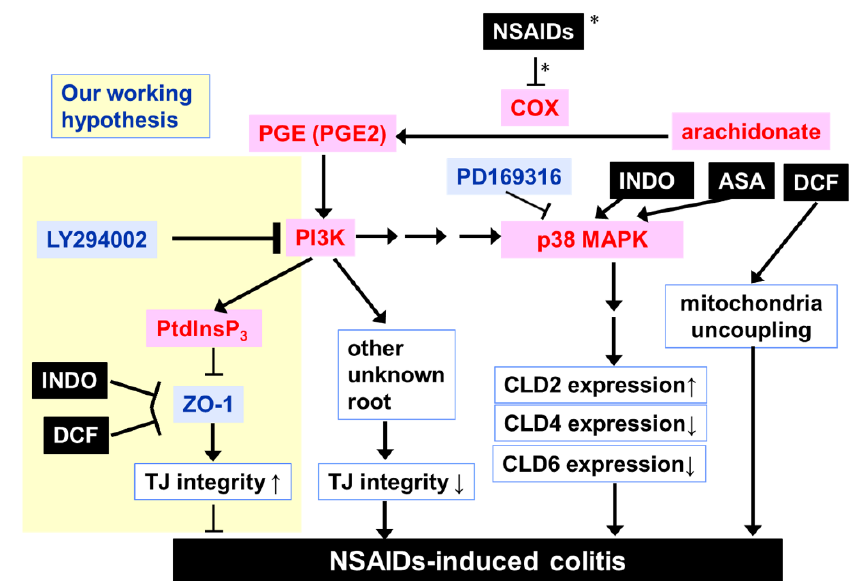
Figure 7. Potential molecular mechanisms of NSAIDs with the downregulation of the integrity of tight junctions. Our current working hypothesis based on the PDZ domain-derived competitive interaction between CLDs and ZO-1 or LNX1 is highlighted in pale yellow. When INDO and DCF interfere with the contact of ZO-1 to CLD-2, LNX1 may promote ubiquitination-dependent internalization of CLD-2 from the membrane; thus, TJ integrity is weakened. Other potential contributions of arachidonate and PGE2 are also illustrated. The substances and enzymes that mediate TJ opening are drawn in red. Only the pathway with an asterisk is that of TJ-enhancement, and the other NSAIDs are decreasing TJ-integrity (see text).